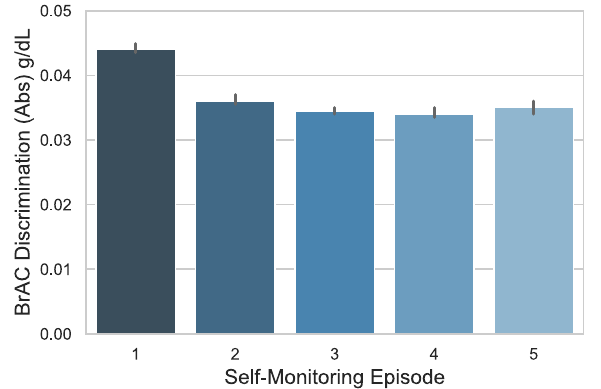
Fig. 6 Improvements BrAC discrimination as a function of self- monitoring. Episodes of self-monitoring were de fi ned as any new BrAC measurement occurring at least 12 h after the prior BrAC measurement. Higher values on the y -axis denote a greater discrepancy between the true BrAC and the user ’ s self-estimated BrAC (on average, an underestimate of the true BrAC). Values where both the true BrAC measurement and the user ’ s BrAC estimate were both zero were excluded, as such values likely indicated product tests or demonstrations rather than true self-monitoring. For this graph, the absolute value of BrAC discrimination values were averaged within each user-episode and graphed as a function of the fi rst fi ve episodes of self-monitoring, with the error bars represent- ing the 95% con fi dence interval. The number of observations by episode were: (1) 25,503, (2) 19,292, (3) 15,676, (4) 13,193, and (5)